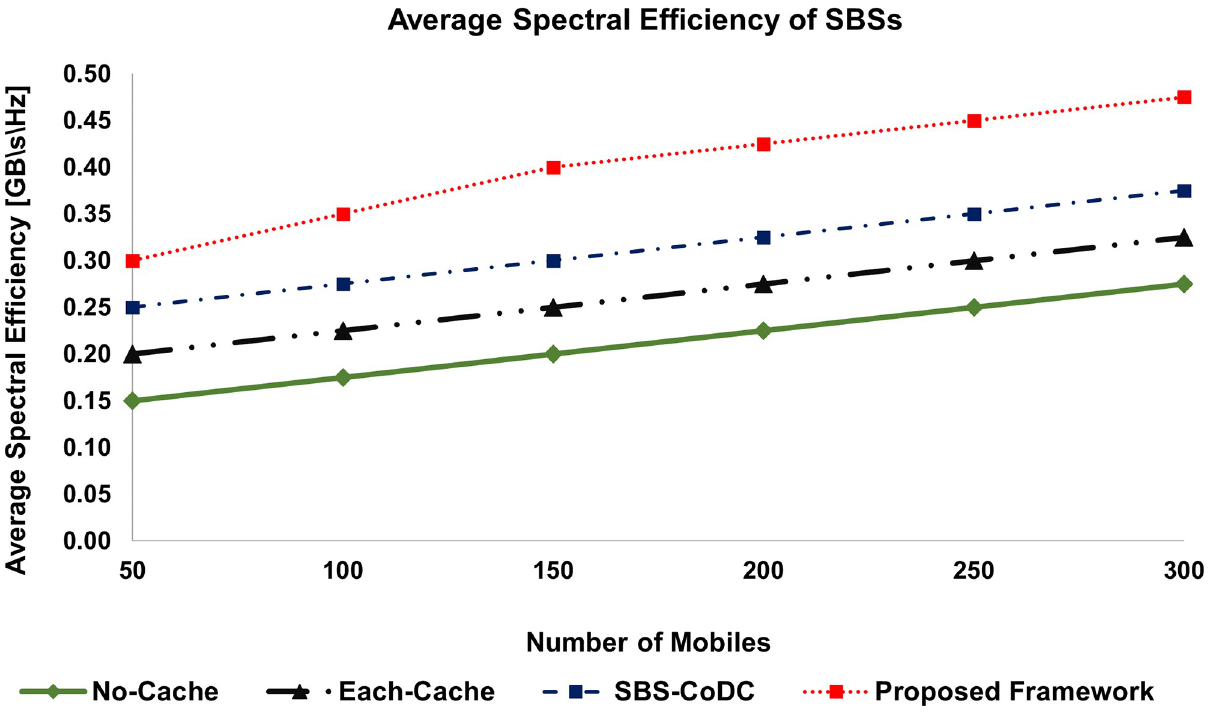
Fig 15. Average spectral efficiency of SBSs as compared to existing schemes.